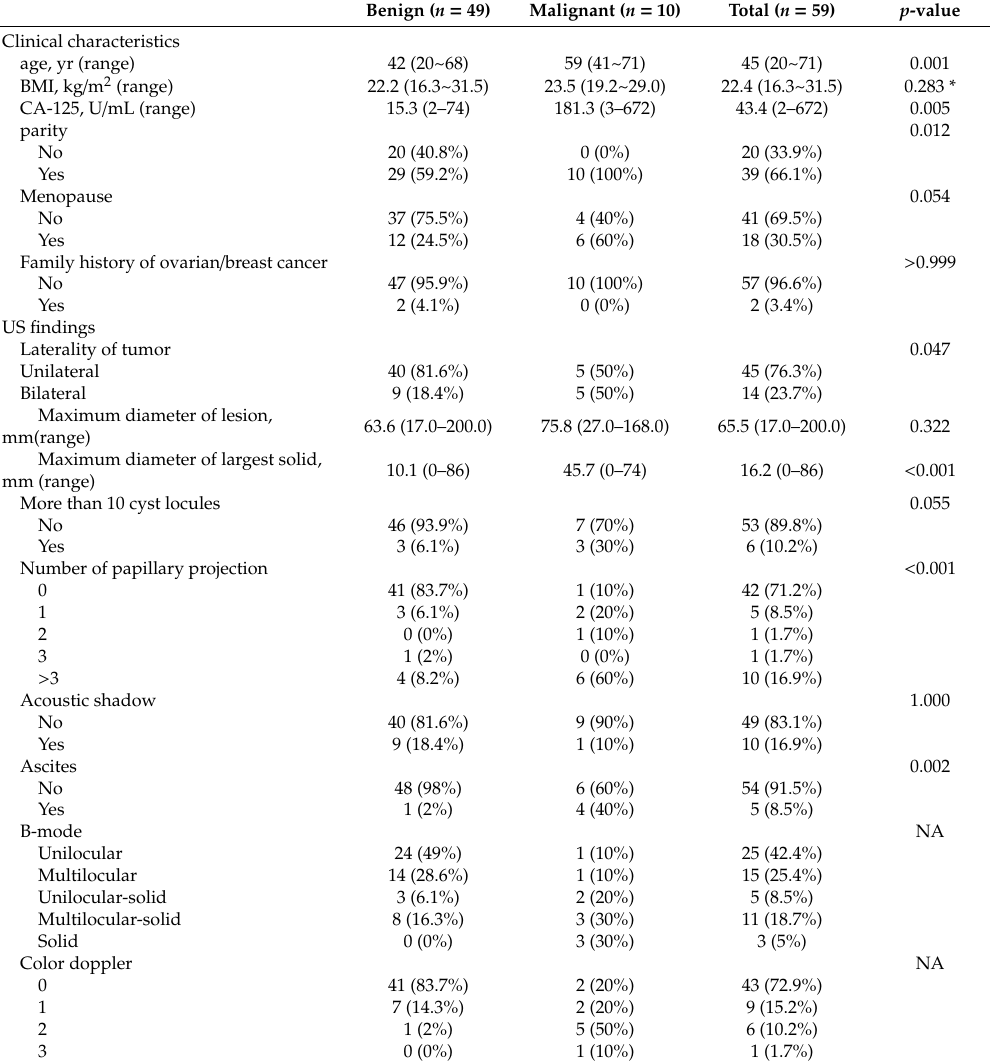
Table 1. Participants’ demographics and ultrasonography (US)